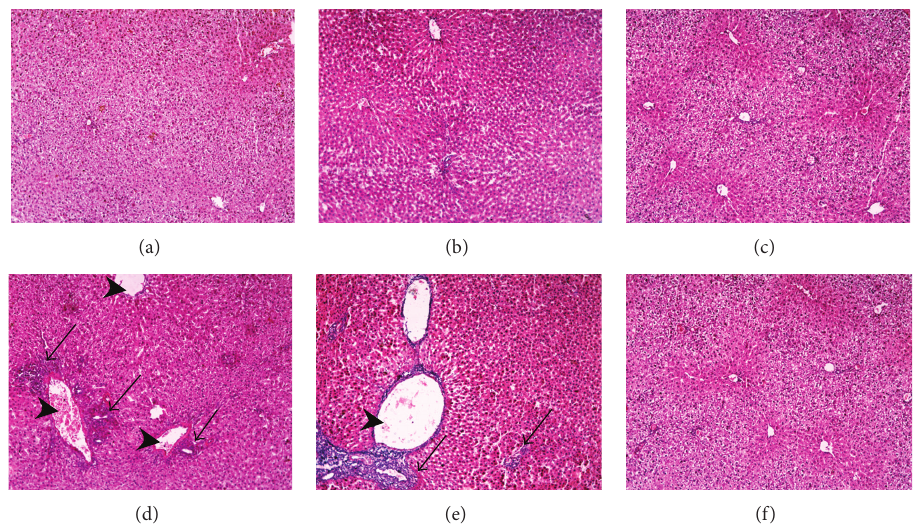
Figure 1: Effect of fenofibrate (FEN) and pioglitazone (PIO) on liver histopathological profile in cyclophosphamide (CP)-treated rats. Representative photomicrographs of liver from: ((a), (b), and (c)) control and FEN and PIO groups, respectively, showing no pathological changesinhepatocytes,(d)CP-treatedgrouppresentingwithlossofnormalhepaticarchitecture,congesteddilatedcentralvein,inflammatory cellular infiltration, and perivenular hepatocytic necrosis, (e) CP/FEN group showing congested dilated central veins with focal inflammatory cellular infiltration and degenerative necrotic cells, and (f) CP/PIO group demonstrating normal liver histology. Arrowhead: dilated central vein, black arrow: inflammatory cellular infiltration ( × 100). The histological changes were scored, and results are expressed in Table